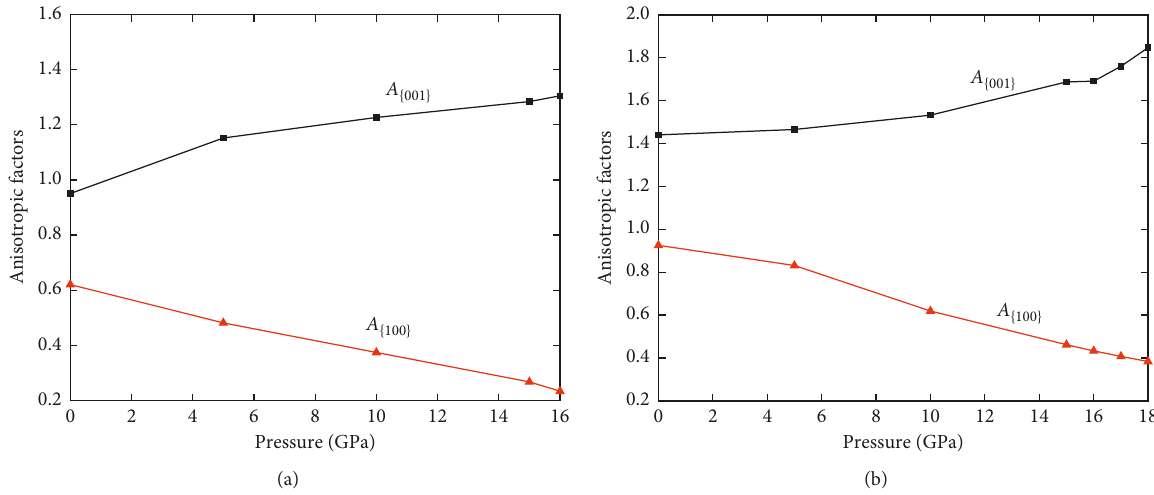
Figure 5: The pressure dependence of the anisotropic factors for (a) LiFeAs and (b)